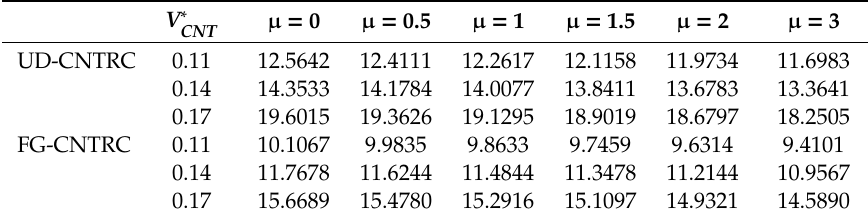
Table 3. Nondimensional critical buckling load for simply- simply (S-S) CNTRC curved beams with L / h = 10, α = π / 3.